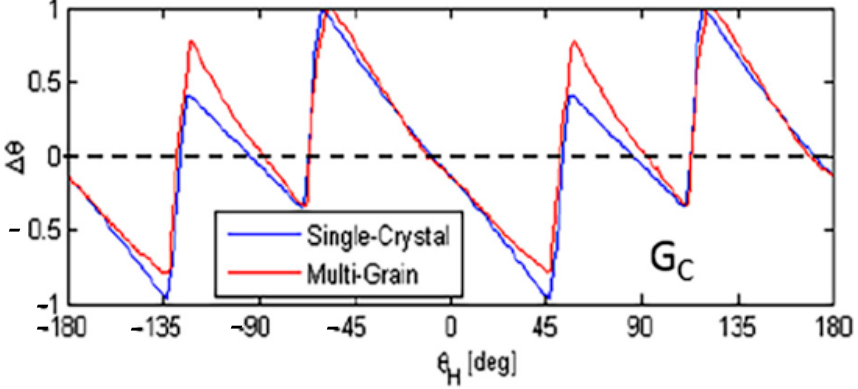
Figure 7. Goss texture evaluation by means of LADM-based measurements of the lag angle between H and M during rotational magnetization of a GOES sample [54] (p. 141). The blue and red traces indicate, respectively, the lag angle values during a rotational magnetization of a single grain sample and a multiple grain sample. The zero crossing points of the lag angle Δϑ are not in correspondence with the orientation indicated above.